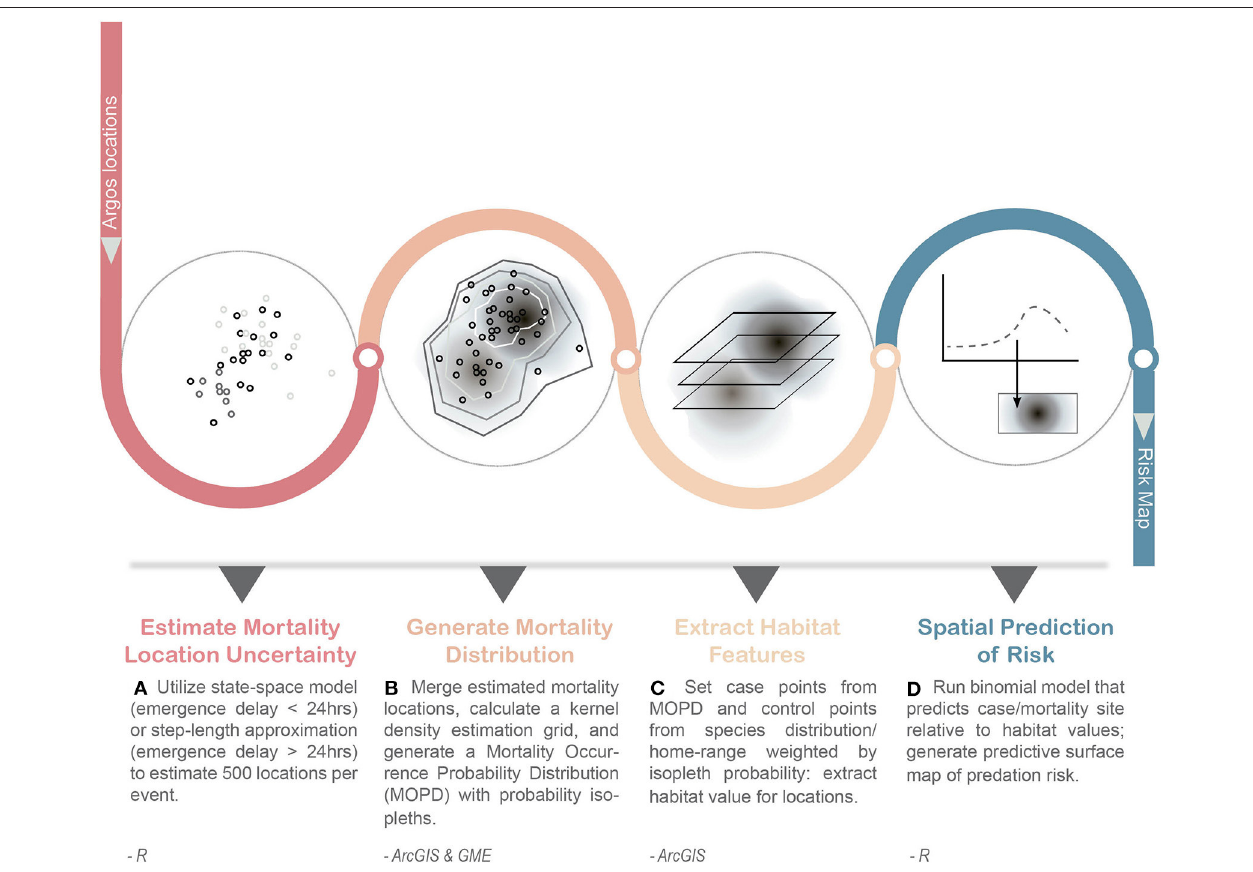
FIGURE 1 | General work-flow for developing a spatially explicit risk map of predation for marine top predators. Inputs into the workflow include Argos location data from pop-up transmitters (e.g., LHX tags, miniPATs) and external Satellite Data Recorders (SDRs). This approach captures the uncertainty of emergence location for mortality events (A,B) and incorporates it into the determination of case and control points used in subsequent habitat modeling of risk (C,D) . Steps were conducted in program R, ArcGIS, and Geospatial Modeling Environment (GME